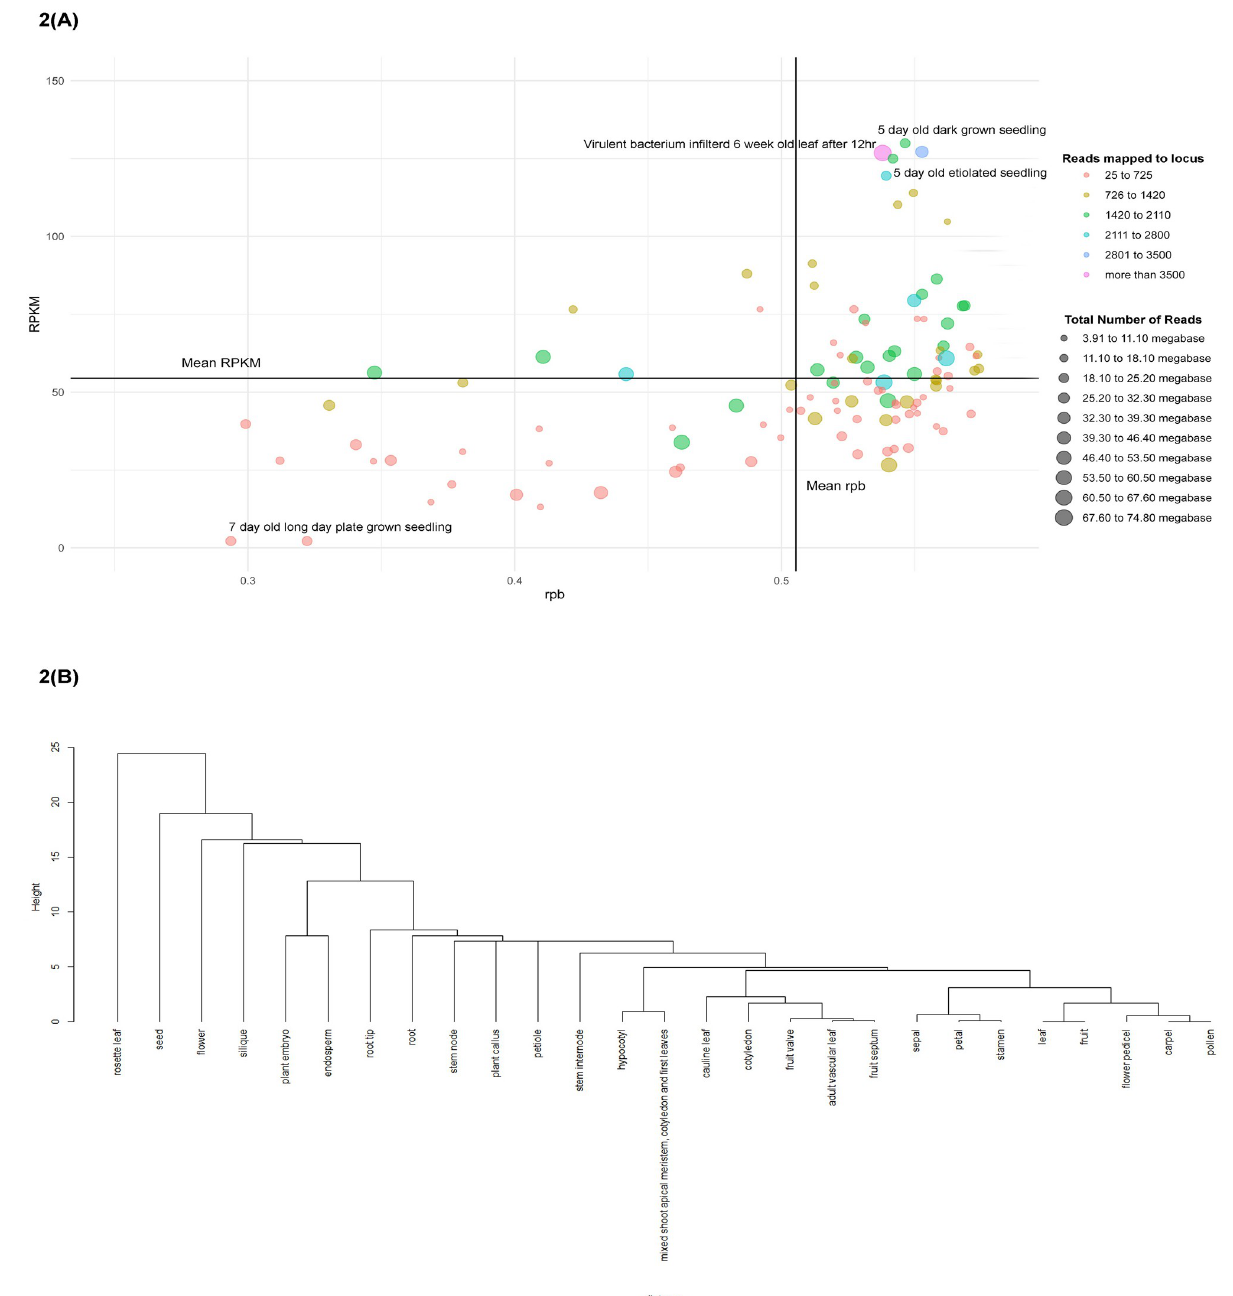
Fig 2. Insight of expression data based on different parameter; A: Insight on ACD11 gene data on rpb vs RPKM based on reads mapped to locus and total number of reads; B: Cluster of plant different portion based on gene expression similarity.